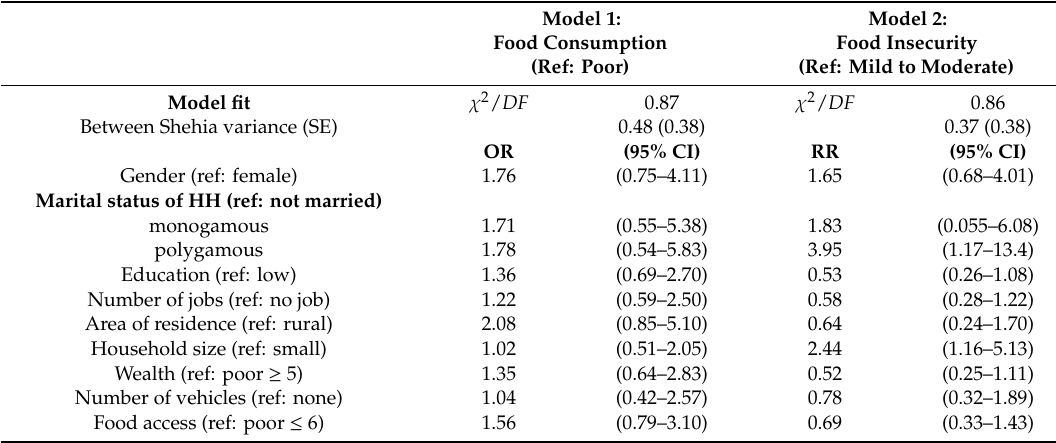
Table 4. Associations of socioeconomic and demographic correlates of 196 households with food consumption (Model 1) and food insecurity (Model 2) in terms of odds ratios (OR) and 95% confidence intervals (CI) as well as model fit (generalized chi-square / degrees of freedom), respectively. Model 2: Model 1: Food Insecurity Food Consumption (Ref: Mild to Moderate) (Ref: Poor) Model fit χ 2 / DF